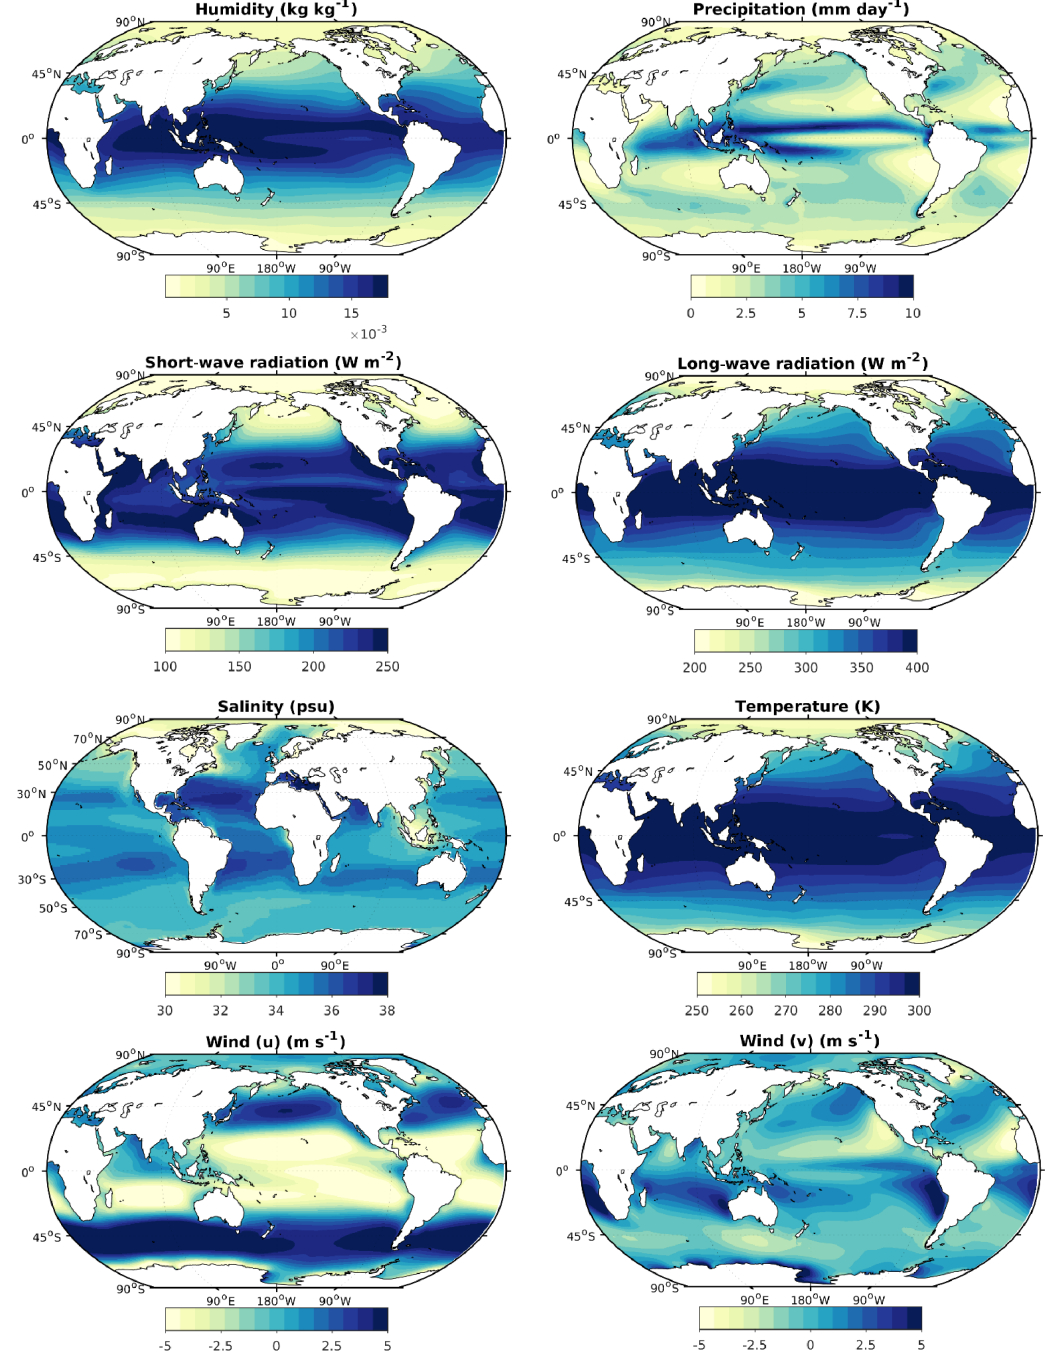
Figure A2. Annual mean for each of the variables (see Table 1) for the piControl CMIP5/PMIP3 experiment.